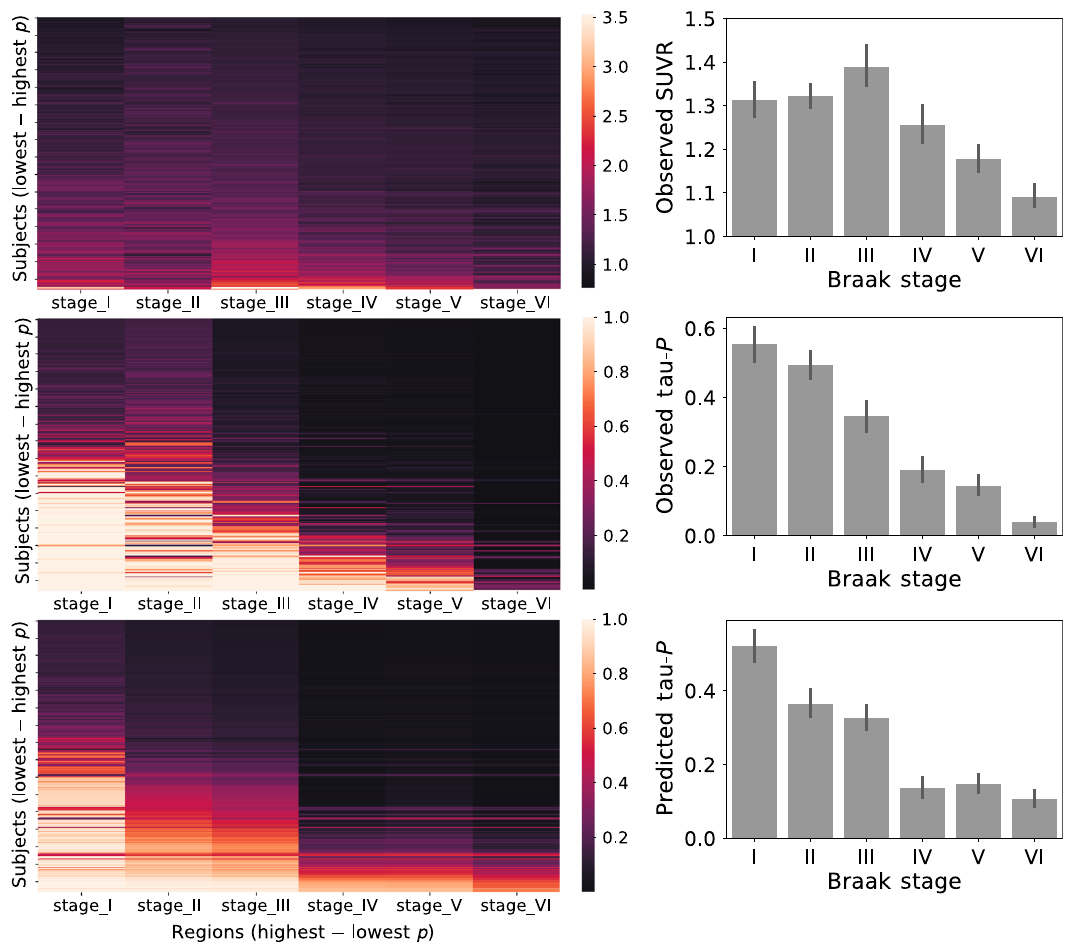
Fig. 2 Tau-positive probabilities recapitulate Braak staging. Each brain region was divided into one of six "Braak stage" ROIs, based on which Braak stage the region fi rst shows abnormal tau (as described in ref. 83 ). (Left) Each row is a subject sorted top-bottom by least to most overall tau. Each column is an Braak stage ROI, sorted left to right by most to least overall tau. Warmer colors represent higher SUVR values (top), observed tau-positive probabilities (middle) or predicted tau-positive probabilites from the best- fi tting ESM (bottom). (Right) The same relationship shown in a barchart format. Error bars represent standard error of the mean. Conversion to tau-positive probabilities creates a sparse distribution of values demonstrating a progression reminiscent of the staging described in the autopsy